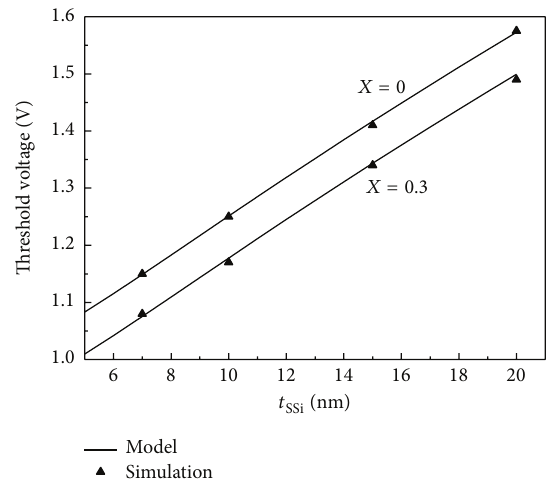
Figure 6: Threshold voltage versus strain 𝑋 . 𝑉 𝑑𝑠 = 1 V, 𝐿 𝑔 = 50 nm, = 29 , 𝑡 = 3 nm, and 𝑡 = 10 nm. 𝜀 ox ox SSi